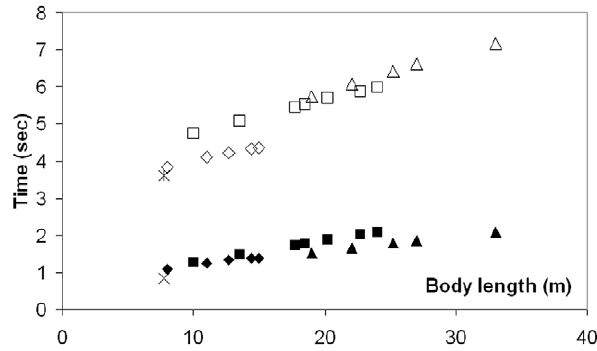
Figure 7. The time scales of engulfment drag. Engulfment time ( t engulf ; empty symbols) and VGB push time scale ( t ; filled symbols) for humpback (diamonds), fin (squares), blue (triangles) and minke whales (starburst and